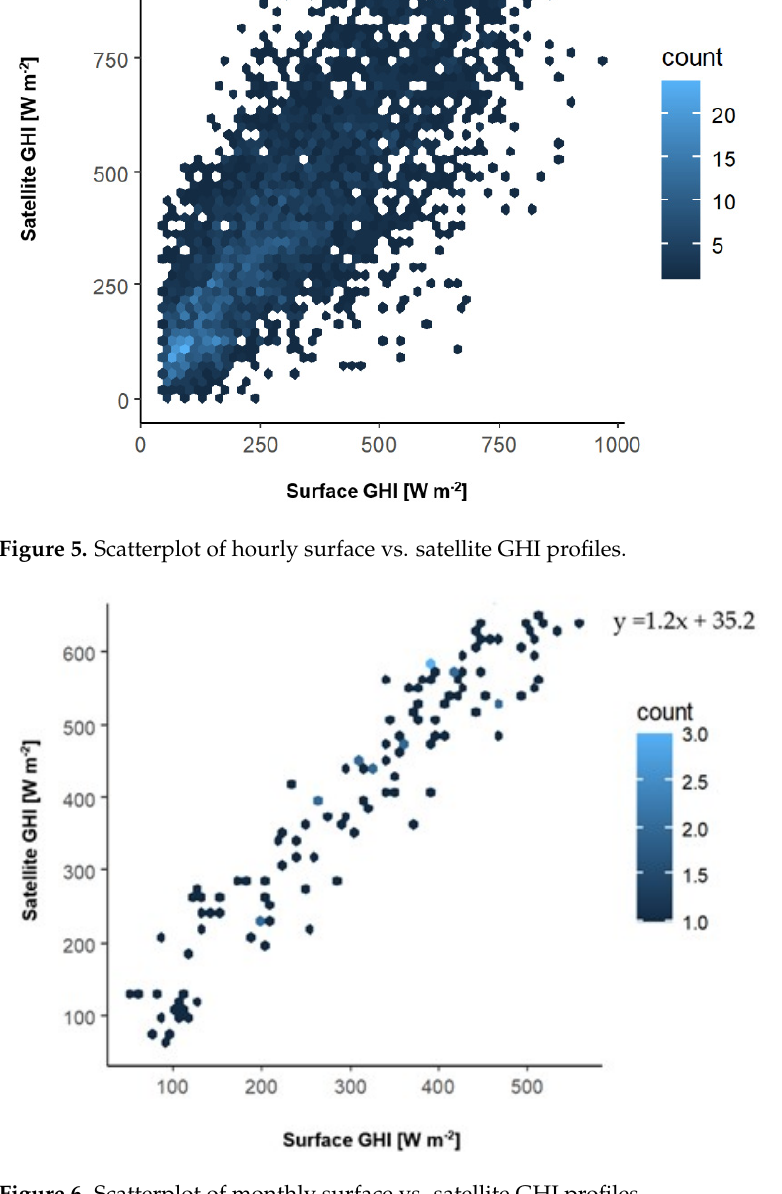
Figure 6. Scatterplot of monthly surface vs. satellite GHI profiles.